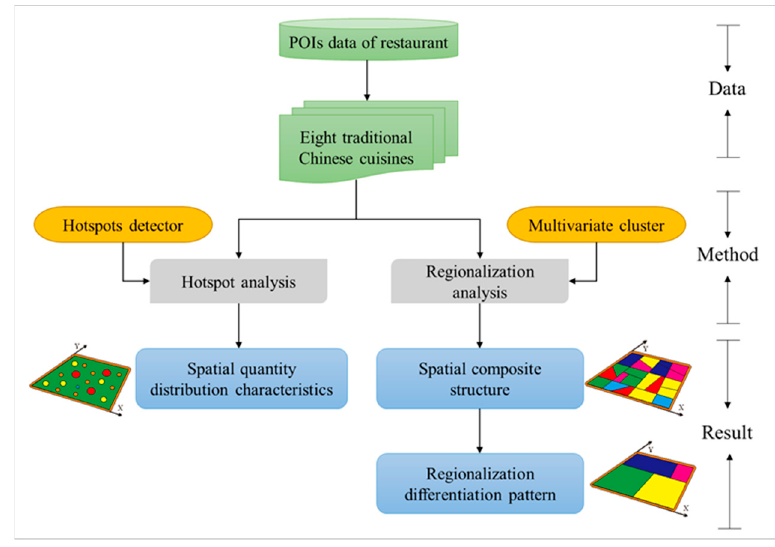
Figure 2. Research framework (analysis data, method, and result).